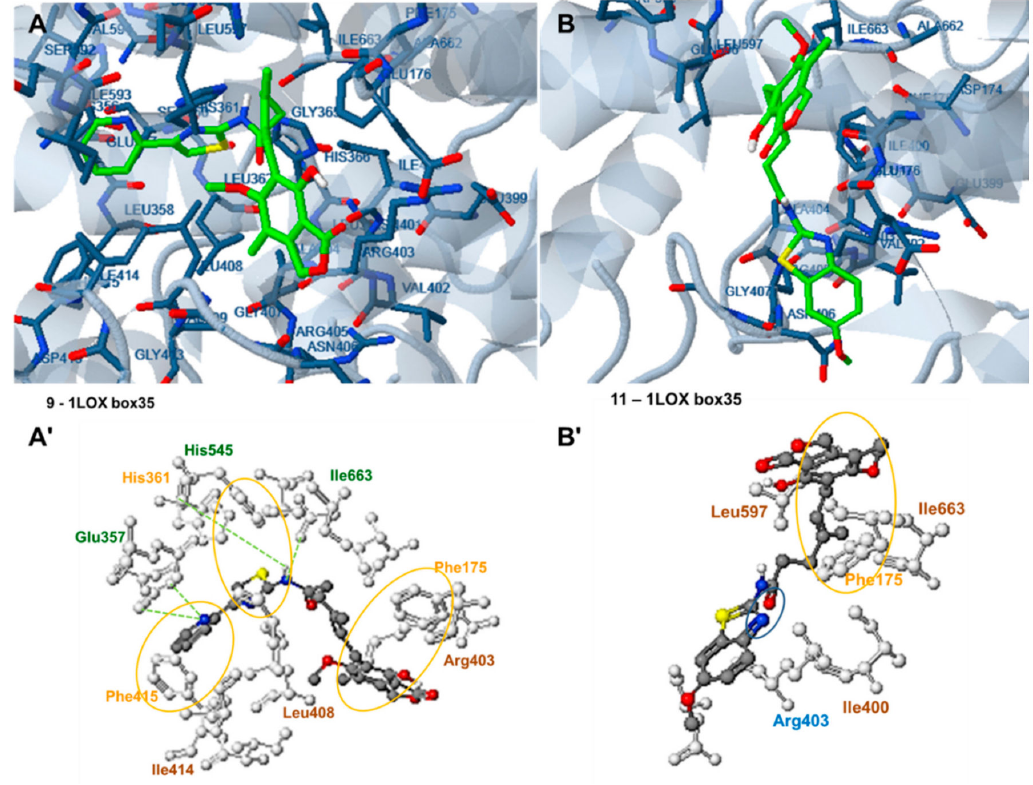
Figure 6. Docking analysis of the most active (IC50 2.5 µ M) compound 9 , ( A , A (cid:48) ) and the less active, (IC 50 156.25 µ M) compound 11 ( B , B (cid:48) ) to the active site of the rat 15-LOX structure PDB ID: 1LOX (target box 35). Green: hydrogen bond interactions, Blue: polar interactions, yellow: pi interactions, brown: hydrophobic